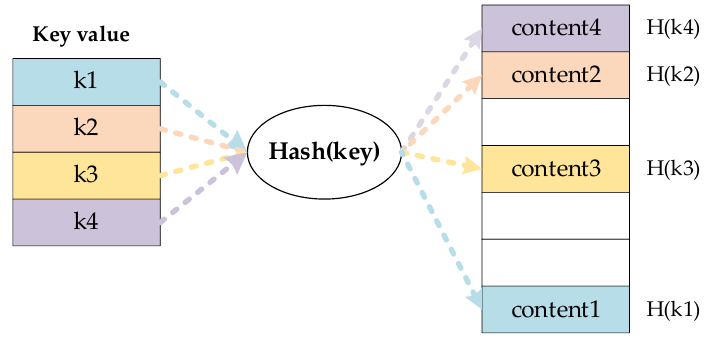
Figure 5. Schematic of hash function mapping.